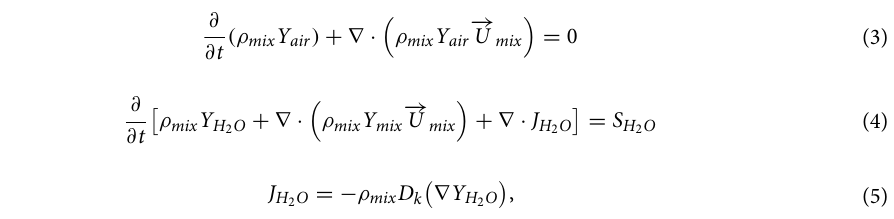
where −→ U mix is the mass-averaged mixture velocity, S H is the mass source of water vapor due to saliva droplets 2 O evaporation, J H and D k are the diffusion flux and the kinematic diffusivity of water vapor in the air mixture, 2 O respectively. The ideal mixture between dry air and water vapor is assumed to share the same local velocity, pressure, and temperature. Hence the conservation equations of momentum and energy are combined into the mixture